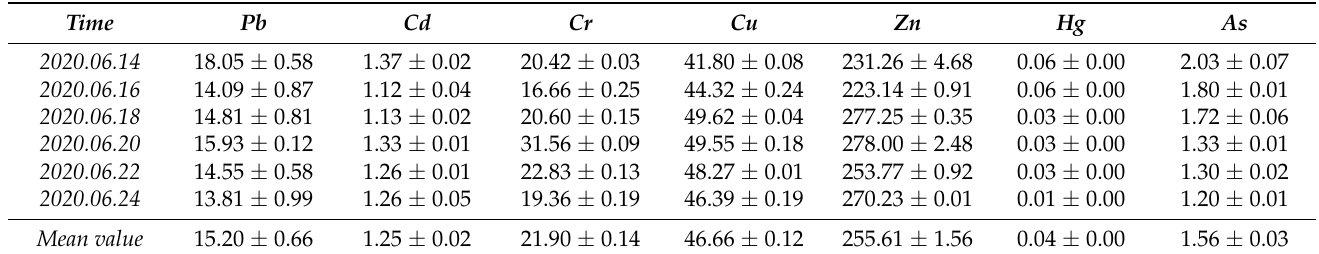
Table 2. Concentration of heavy metals in composting piles